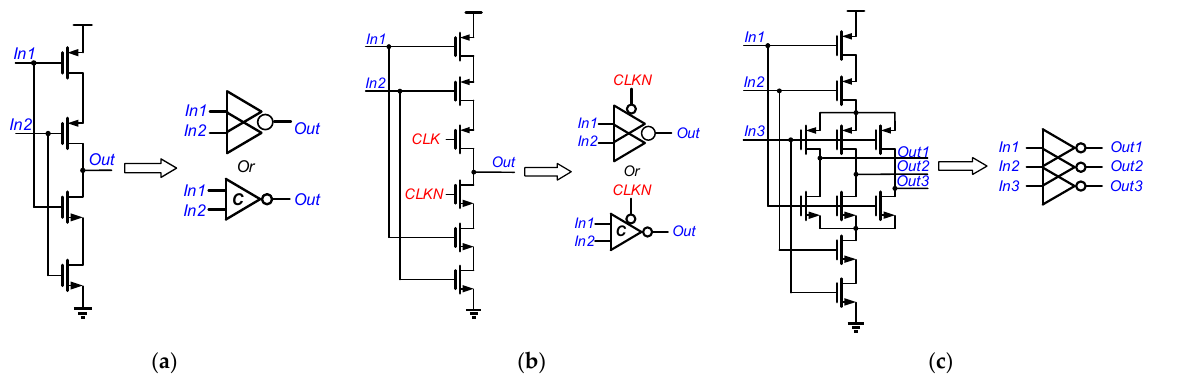
Figure 1. Components used in the previous design: ( a ) two inputs CE; ( b ) clock-controlled two inputs CE; ( c ) three inputs and three outputs CE.